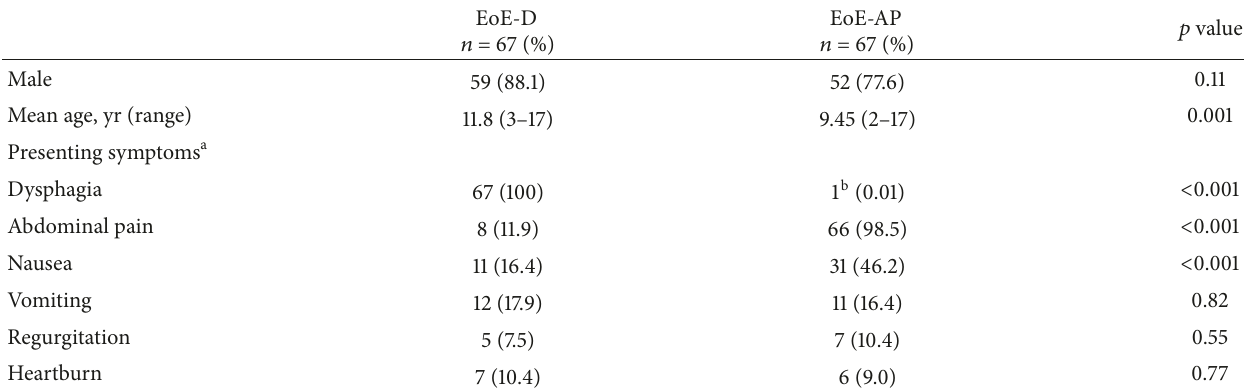
Table 1: Demographics and Symptoms of Patients with Eosinophilic Esophagitis.